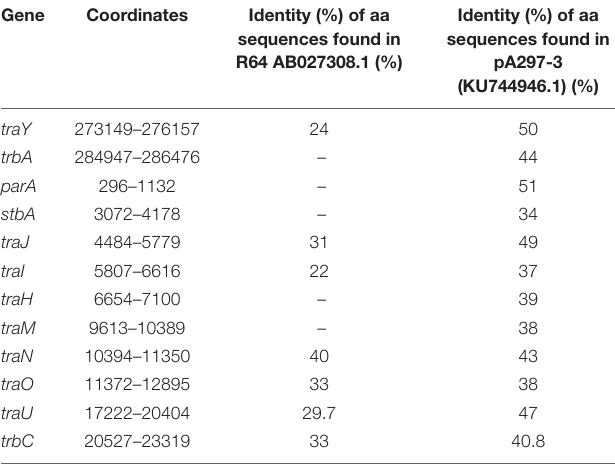
TABLE 2 | Identification of the pALWED1.1 genes involved into the formation of MPF